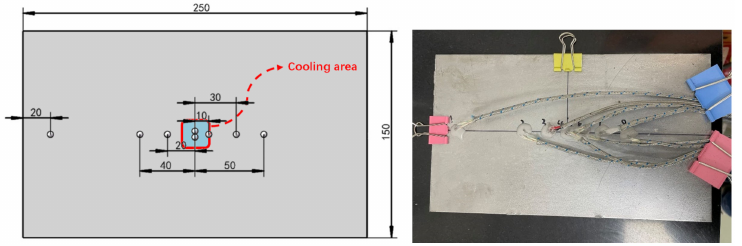
Figure 11. Schematic diagram of the welding position of the thermocouple (unit in mm).